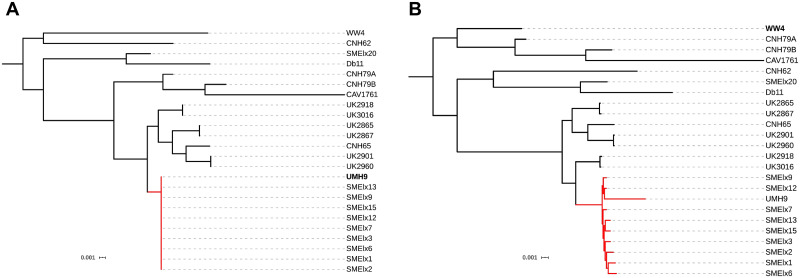
Impact of reference choice on phylogenetic trees of S.marcescens.ML trees included the selected reference sequences from S. marcescens and the consensus sequences calculated from alignments against strains (A) UMH9 and (B) WW4. Outbreak clade is shown in red.